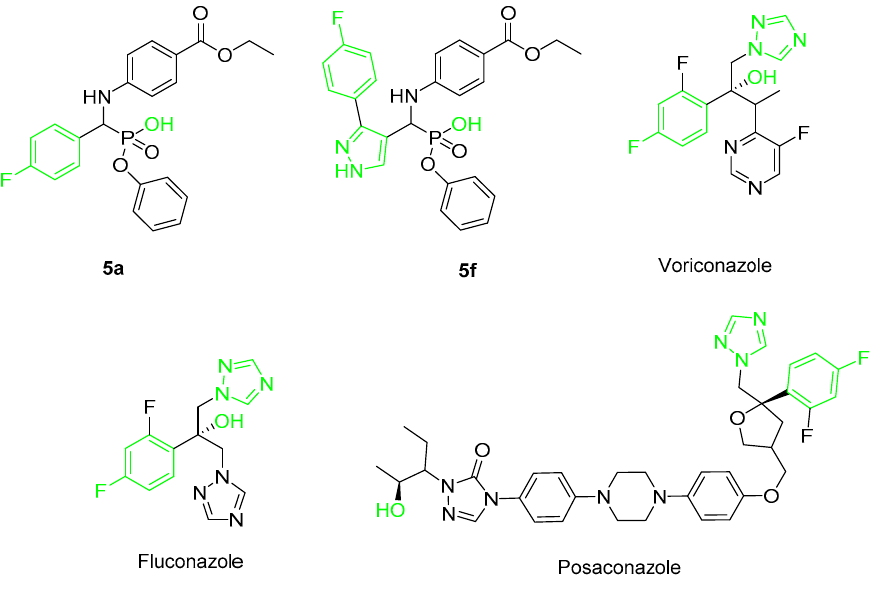
Figure 2. Structures of 5a , 5f and common antifungal azoles for comparison. Table 4. In vitro susceptibilities of 23 strains of Scedosporium against antifungal drugs and compound 5f . Species (n)